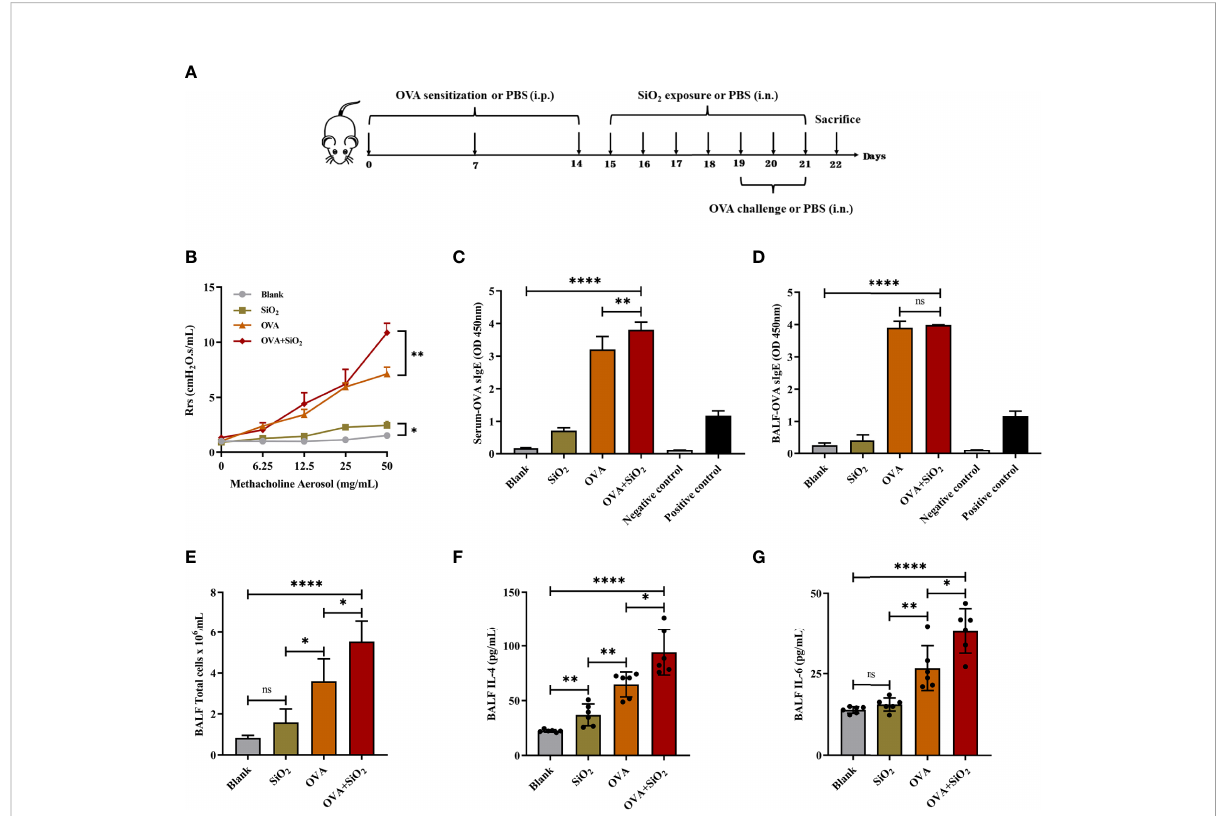
FIGURE 3 Effect of 20 nm SiO 2 exposure on the allergic asthma mouse model. (A) The schedule for the OVA-induced asthma model and the procedure of intranasal instillation of 20 nm SiO 2 or PBS in the OVA-induced asthma model. (B) Measurement of airway hyperresponsiveness in the OVA- induced asthma model. The values of respiratory system resistance (Rrs) were measured 24 h after the last OVA challenge by exposure to increasing doses of methacholine. Data are presented as the mean ± SEM. (C, D) Levels of OVA-speci fi c IgE in BALF and serum. (E) Total cell counts in BALF of the OVA-induced asthma model. Data are presented as the mean ± SD. (F, G) Levels of IL-4 and IL-6 in BALF supernatant of the OVA-induced asthma model. Data are presented as the mean ± SD. The unpaired t test or ordinary one-way ANOVA was used to compare different groups. * P < 0.05, ** P < 0.01, **** P < 0.0001. ns, no signi fi